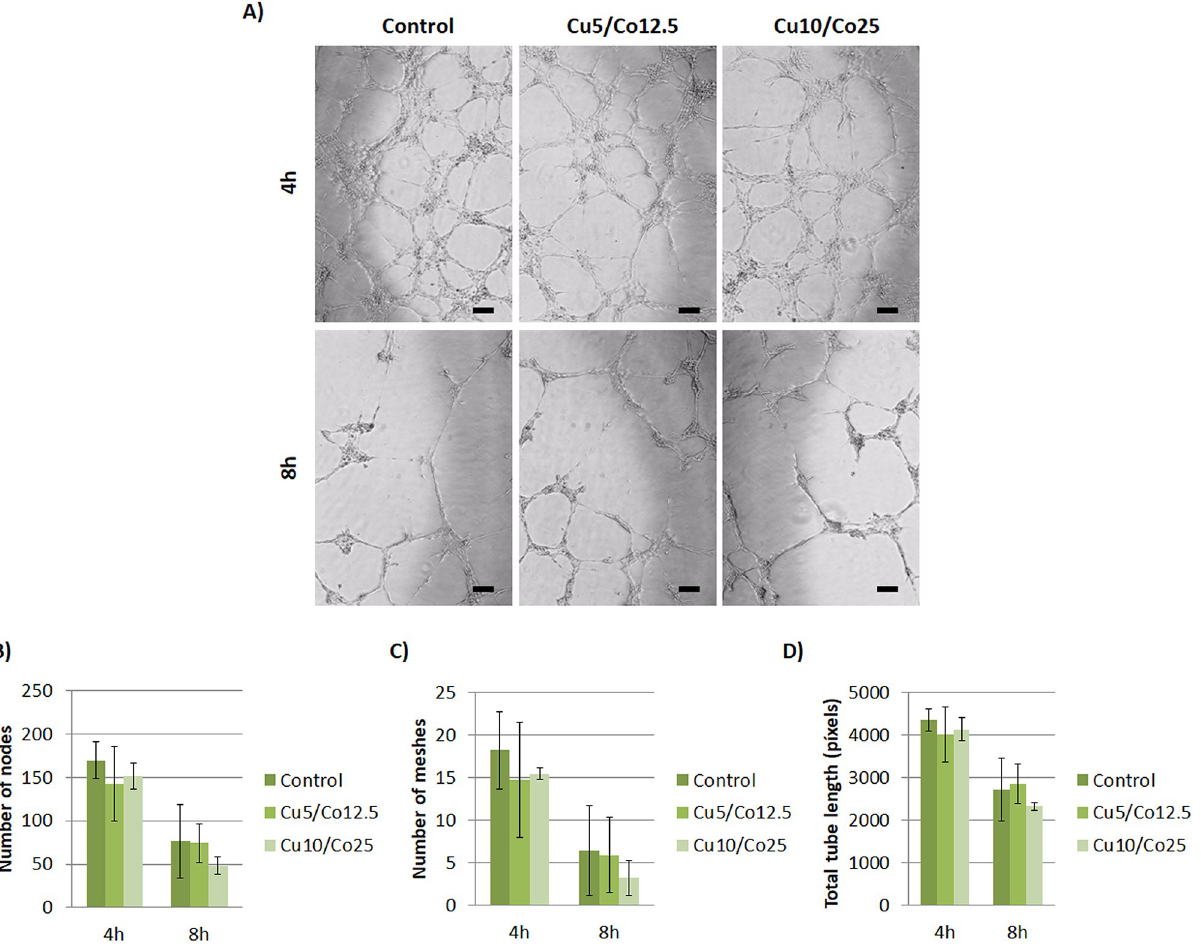
Fig 9. Effects of Cu 2+ and Co 2+ on tubule formation assay with HUVEC. (A) Images of tubules formed under different concentrations of Cu 2+ and Co 2+ at 4 and 8 hours. (B) Analysis of number of nodes, (C) meshes and (D) total tube length of HUVEC at 4 and 8 hours. Abbreviations: Cu5/ Co12.5 = 5 μ M of Cu 2+ and 12.5 μ M of Co 2+ ; Cu10/Co25 = 10 μ M of Cu 2+ and 25 μ M of Co 2+ . Scale bar = 50 μ m.